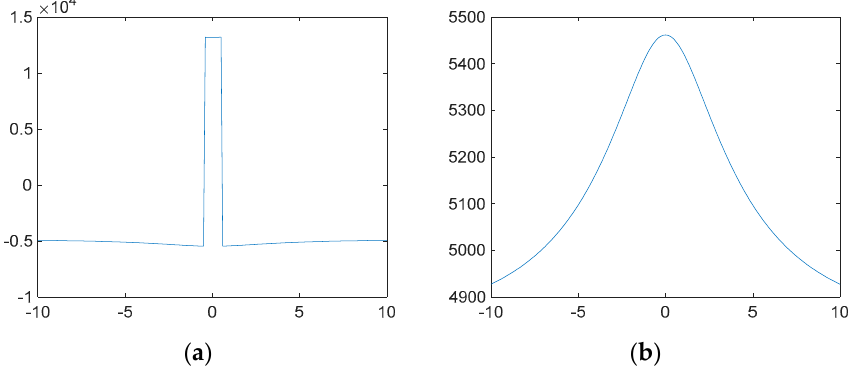
Figure A3. ( a ) Pressure profile along 5 + 5 i and 5 − 5 i in Figure A1. Horizontal scale shows distance in meters and the vertical scale is pressure in Pa. ( b ) Pressure profile along − 5 + 5 i and − 5 − 5 i in Figure A1. Horizontal scale shows distance in meters and the vertical scale is pressure in Pa.